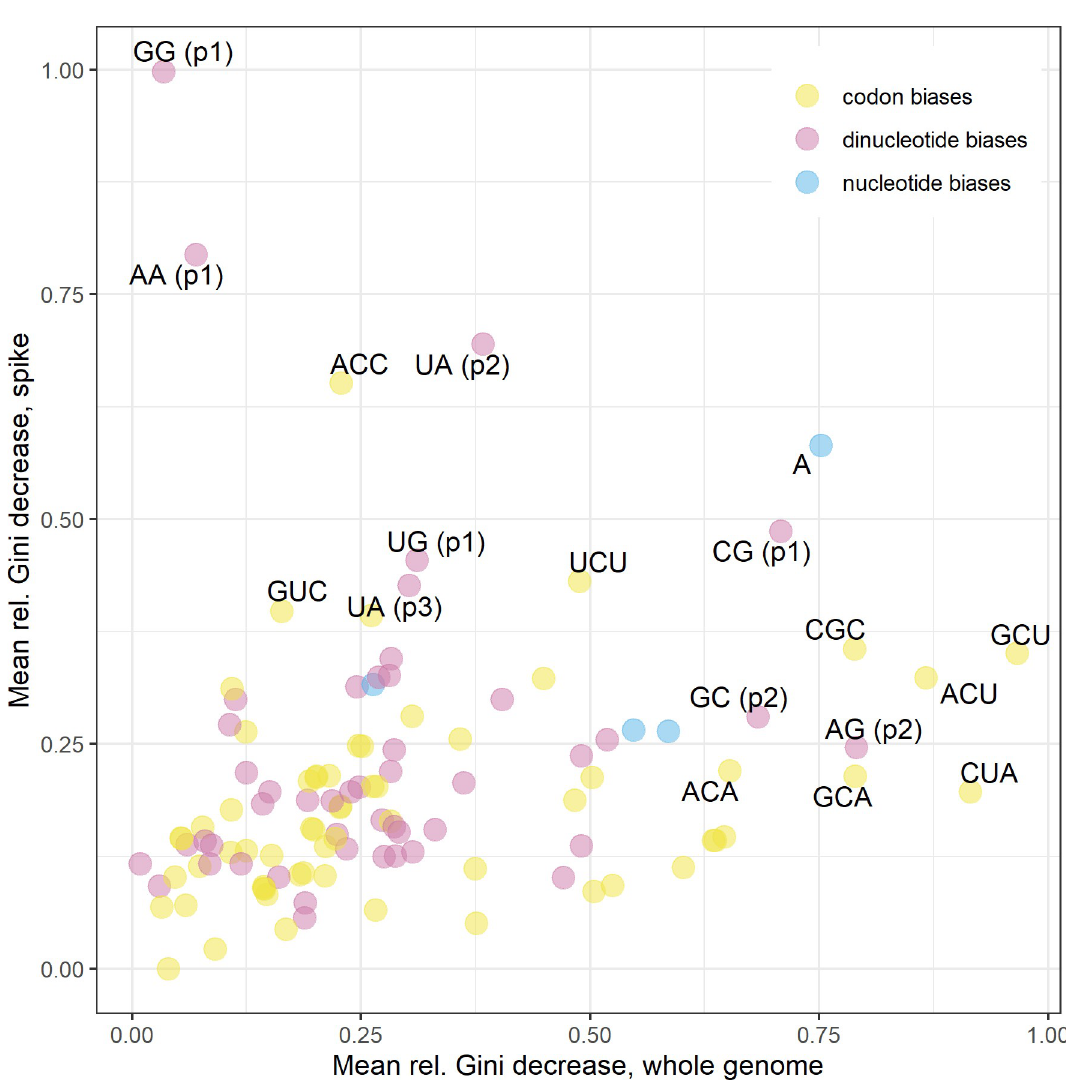
Fig 5. Variable importance of genomic features. Variable importance of genome composition features in ensemble random forest models predicting coronavirus host category from whole genome sequences (x axis) and spike protein sequences (y axis), with labelling of top ten most informative features from both analyses. Points denote mean values of relative decrease in Gini impurity associated with each feature across A) m = 222 and B) m = 185 random forests during hold-one-out cross-validation. Colour key denotes genomic feature